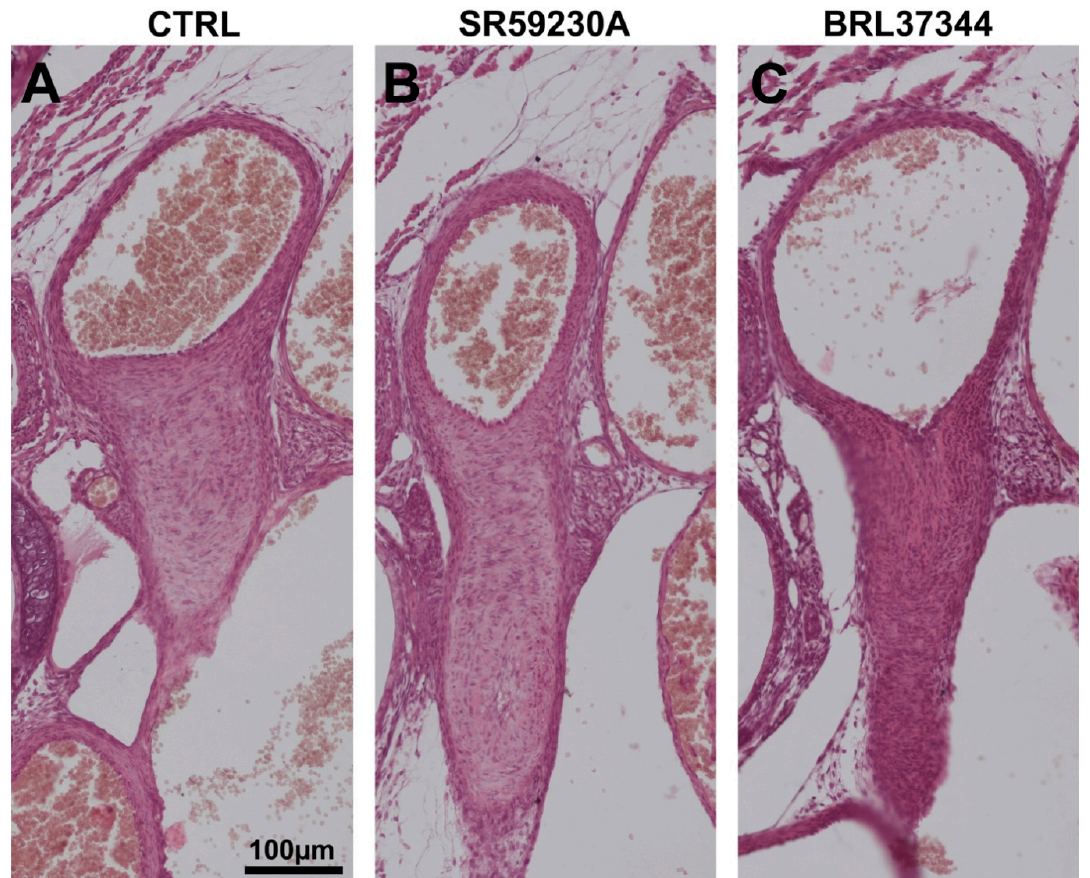
Figure 8. Histological analysis of the ductus arteriosus (DA) in newborn mice. Representatives pictures of DA from pups 7 h after delivery. The DA was completely closed in all the animals of CTRL group (untreated animals), SR59230A ( B ) and BRL37344 ( C ) treated. Scale bar is indicated in panel A . Results are representative of three independent